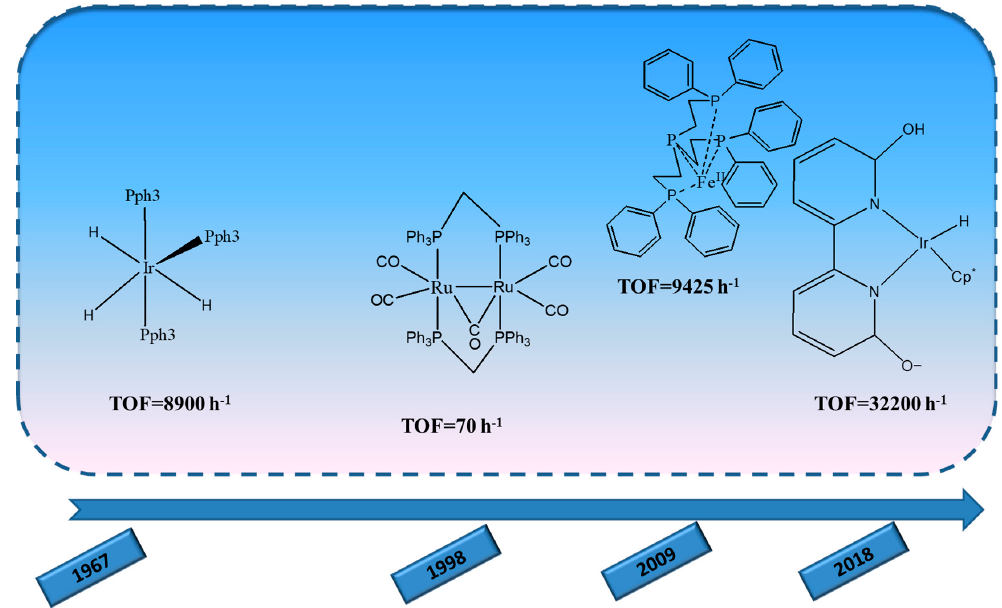
Figure 1. Historical timeline of Turnover Frequencies achieved by representative metal complexes used for formic acid (FA) dehydrogenation, “1967” refers to the work of Coffey [29], “1998” refers to the work of Puddephatt [30], “2009” refers to the work of Beller [43], “2019 refers to the work of Himeda [35].